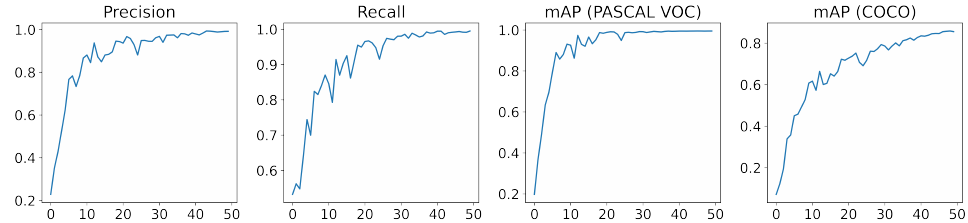
Figure 8. Loss functions of YOLOv5m during the training: bounding box loss with Mean Squared Error ( first graph ), object loss with Binary Cross-Entropy ( second graph ) and classification loss with Cross-Entropy ( third graph ).